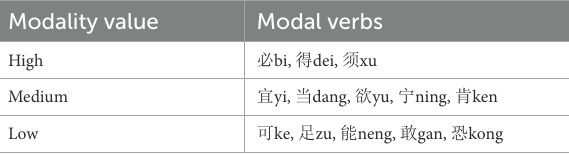
TABLE 2 Corresponding modality values in the original